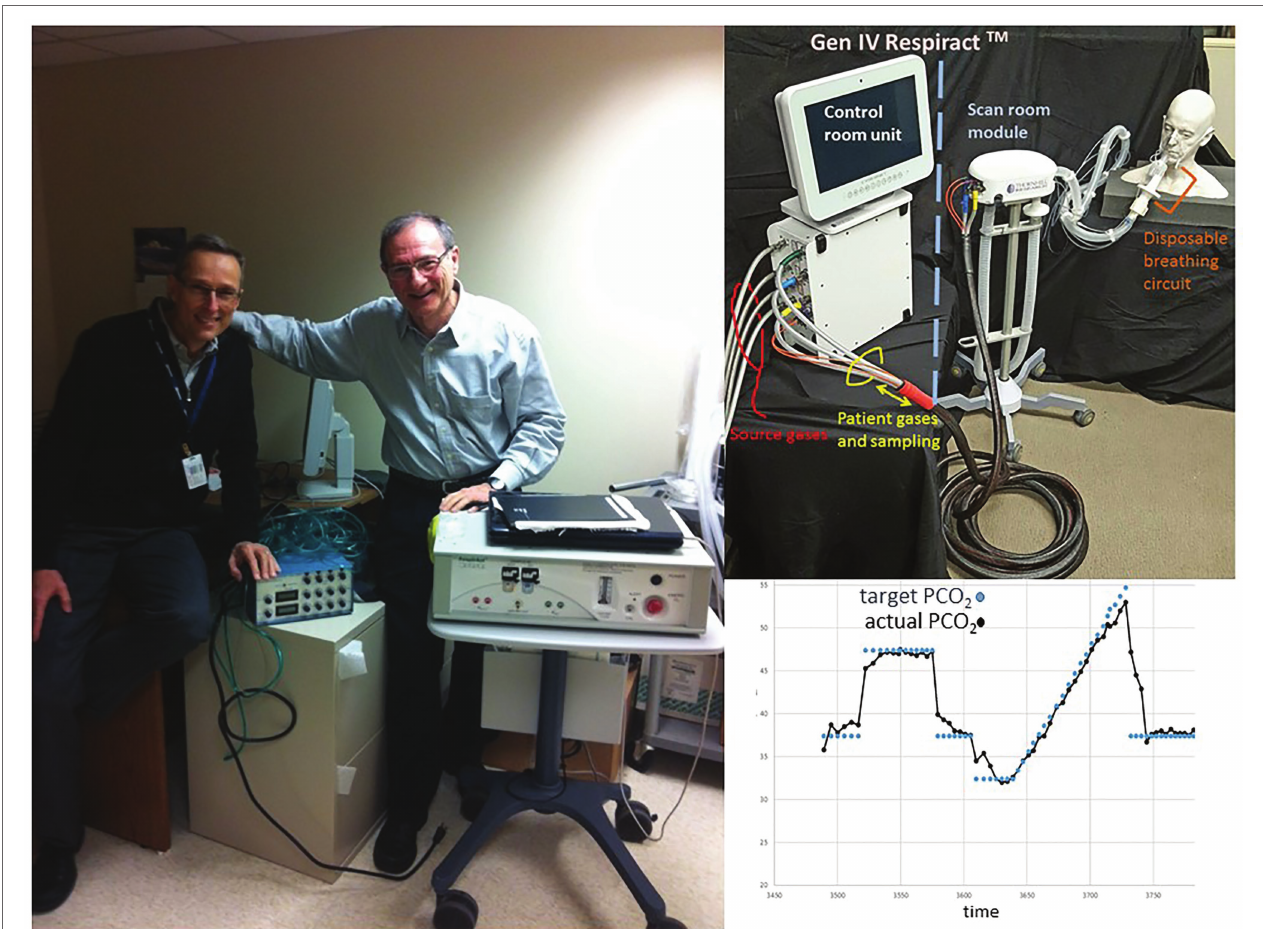
FIGURE 8 | The authors and the generations of gas control devices. Left : DM with hand on Generation 1 end-tidal gas control device used in 1998. JF with hand on Generation 3 gas control device, by then called, RespirAct ™ . Top right : Generation 4 RespirAct ™ . Bottom right : Step-ramp paradigm implemented with Generation 4 RespirAct ™